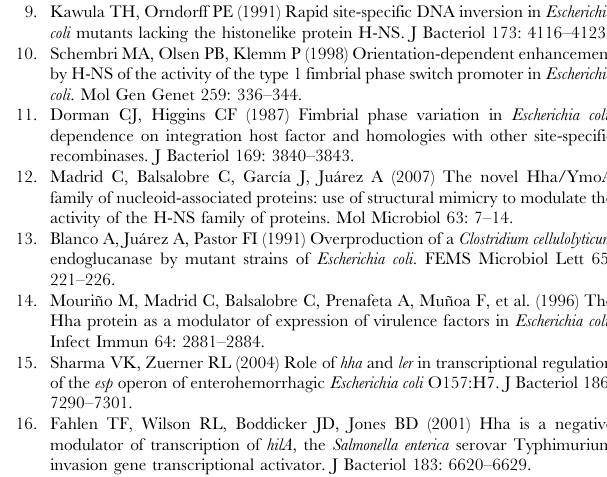
Table S3 List of gene regions bound in vivo by Hha and YbaJ in biofilms cells at 37 u C in LB glu after 24 h as identified by nickel- enrichment DNA microarrays in E. coli K12 BW25113 hha , E. coli K12 BW25113 hha/hns , and E. coli K12 AG1. Signal ratio indicates fold change of pCA24N- hha or pCA24N- ybaJ cells relative to cells with the empty plasmid pCA24N. 1 Gene or intergenic region close to argU . 2 Gene or intergenic region close to ileY . 3 Gene or intergenic region close to appY . 4 Prophage gene or intergenic regions next to prophage genes.